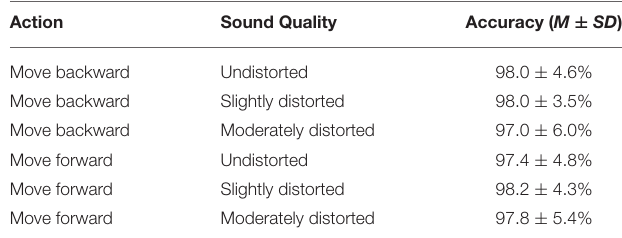
TABLE 1 | Auditory VAAST: accuracy of